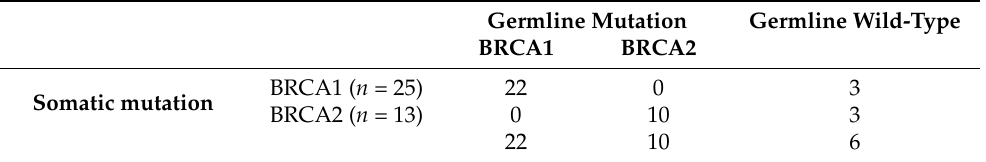
Table 2. BRCA mutation